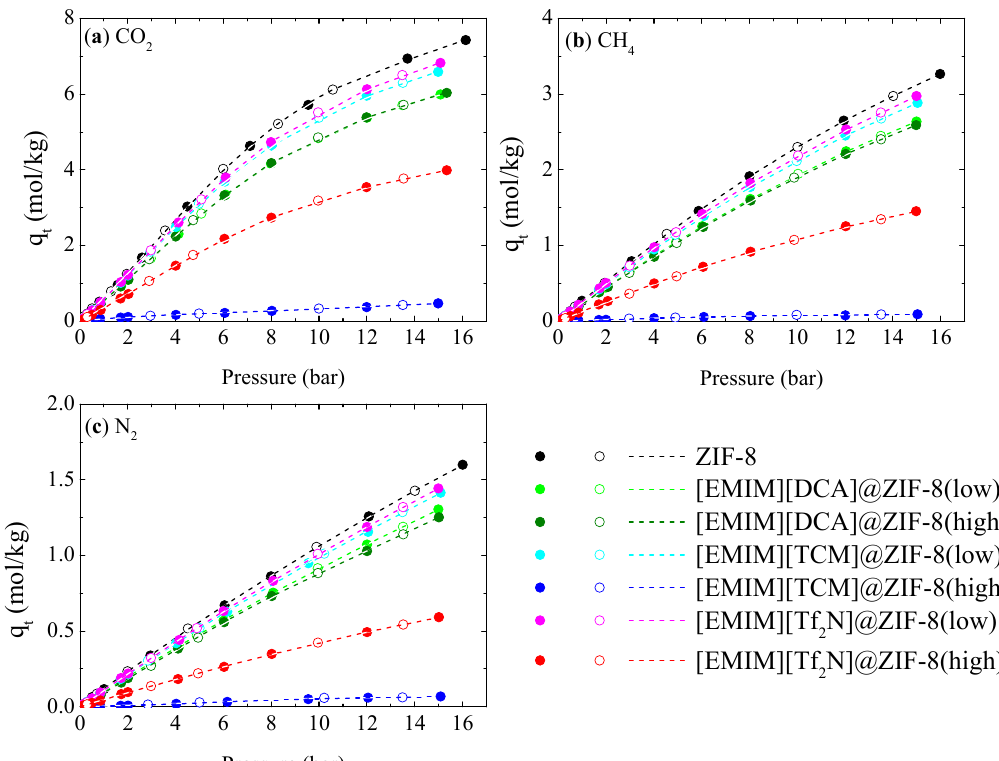
Figure 3. Single-component ( a ) CO 2 , ( b ) CH 4, and ( c ) N 2 sorption–desorption equilibrium isotherms for ZIF-8 and IL@ZIF-8 composites at 303.15 K. Closed and open symbols denote sorption and desorption experimental data points, respectively. Dashed lines represent the 4th-order polynomial fitting to the experimental data points.